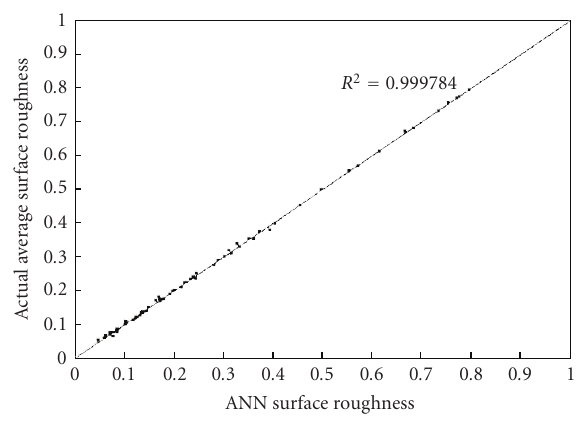
Figure 3: The ANN predictions against the experiment-based re- sults.